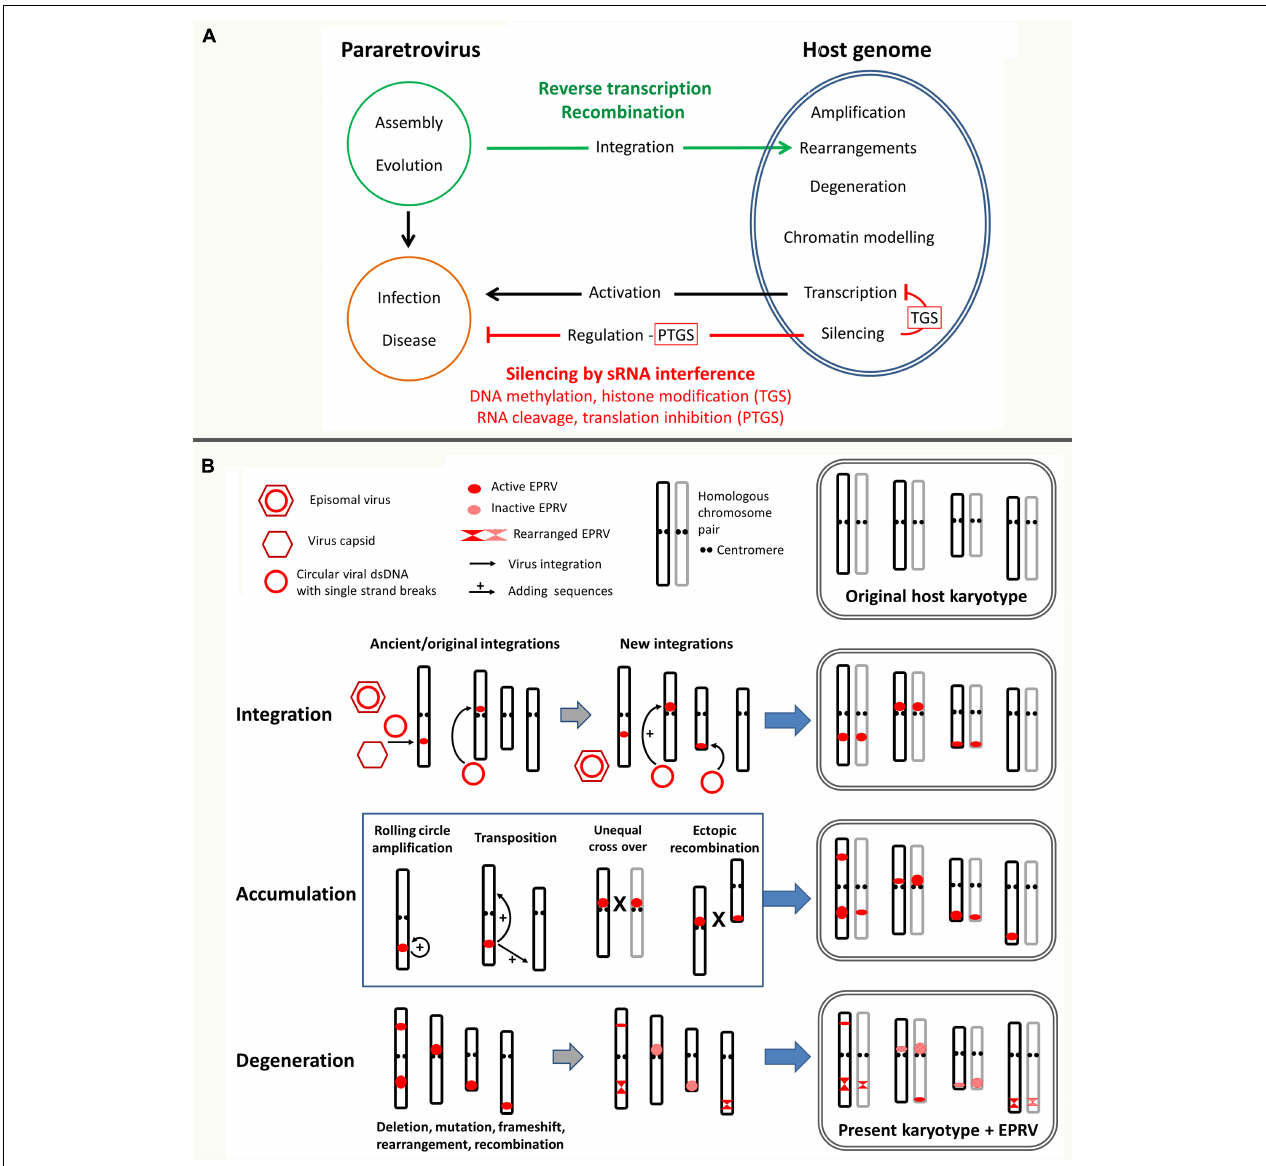
FIGURE 1 | Multiple layers of endogenous pararetrovirus (EPRV) host genome interaction. (A) Overview of involved pathways leading to EPRV invasion of and prevalence in genomes. The ancestral pararetrovirus (PRV) most likely assembled when transcripts of a LTR retrotransposon and an infecting RNA virus recombined allowing systemic plant infection and horizontal transmission. PRVs can become residents of the host genome using illegitimate recombination or reverse transcriptase and accumulate in clusters in certain genomic regions depending on the genomic context and chromatin environment of the host. Endogenous PRVs (EPRVs) usually stay silenced and/or degenerate by mutation, rearrangement or fragmentation (see under b), but sometimes activate. When still active and complete, EPRVs can escape the cellular surveillance system by producing transcripts with terminal repeats. Those serve as template for synthesis of full length PRV episomes that can trigger a viral infection and disease, the same as original episomal PRVs. Furthermore, pararetroviral encoded suppressor of gene silencing counteract the plant defense. EPRV silencing is regulated by RNA interference comprising transcriptional and post-transcriptional gene silencing (TGS and PTGS) as well as DNA methylation and histone modifications (see Figure 2 ). (B) Detailed view of EPRV interactions with chromosomes. Prevalence of EPRVs are influenced by three steps: integration, accumulation and degeneration. Four chromosomes and their homologs in lighter shade are shown. Size of the red circle/ellipsoid indicates the number of integrations. Steps of integration, accumulation and degeneration, here depicted separately, can happen simultaneously and over a long time period. The present karyotype shows significant changes in EPRV sequences from the ancient integrations; karyotype rearrangements also occur but are not shown. Integration: Tandem arrays and clusters are generated by simultaneous or subsequent integration and over time through backcrosses and selfing the two homologous chromosomes homogenize. Accumulation: Tandemly integrated EPRVs can amplify by several mechanisms shown in the middle box: rolling cycle amplification, transposition of newly synthesized copies using reverse transcription to sites on the same or different chromosome. Unequal recombination (cross overs) between sites on homologous chromosomes or ectopic recombination between heterologous chromosomes (shown as X) will both amplify and reduce the number of copies at given site. Degeneration: As soon as EPRV copies are integrated, the host genome acts by inactivation through epigenetic silencing mechanisms (see Figure 2 ), but also through sequence degeneration by mutation and deletions that cause frameshifts, fragmentations, rearrangements and recombination.